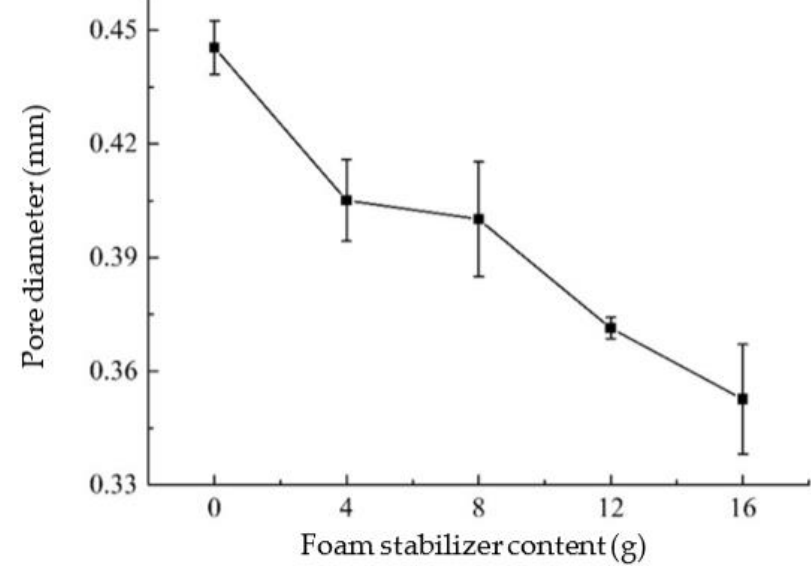
Figure 7. Influence of foam stabilizer content on pore diameter.